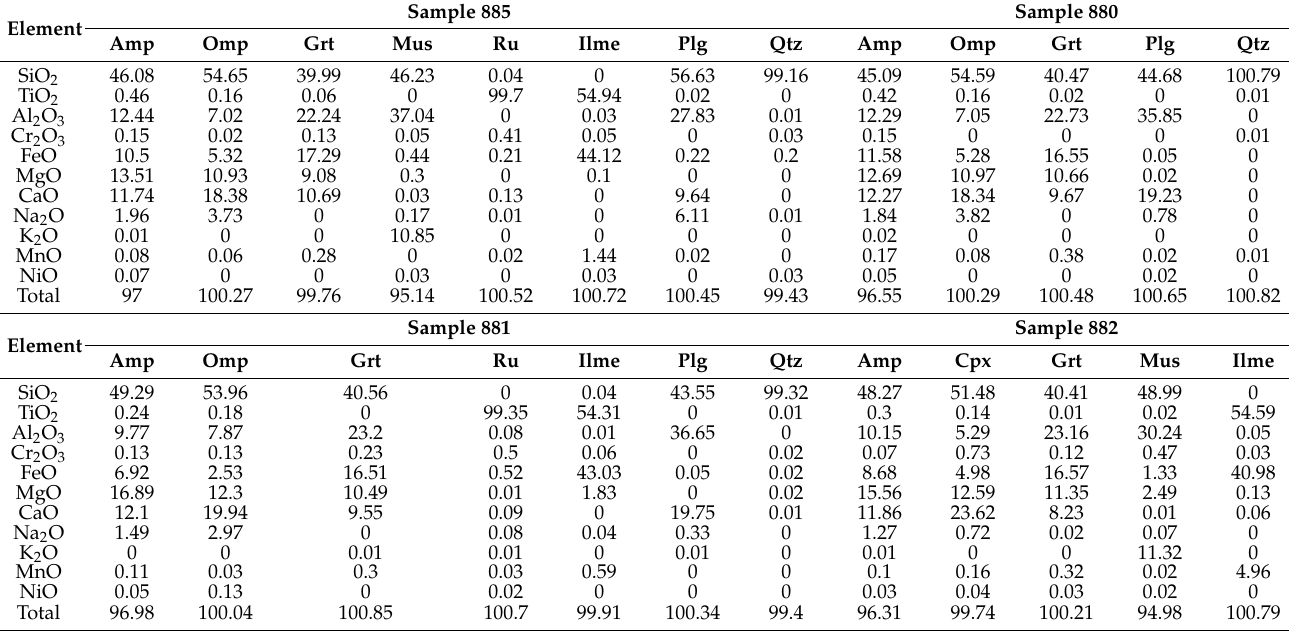
Table 2. Representative chemical composition (oxide mass, %) of minerals in